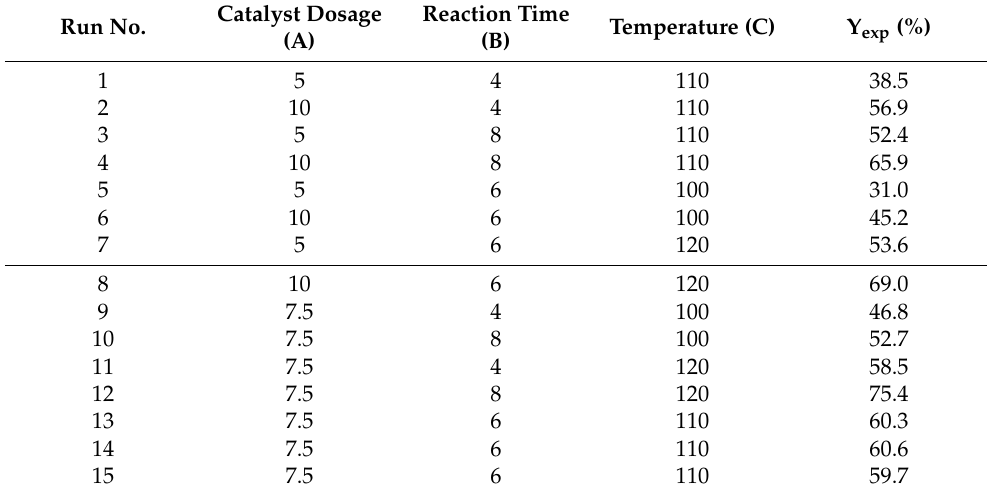
Table 2. Results of the BBD for the LA esterification optimizing process. Catalyst Run No.